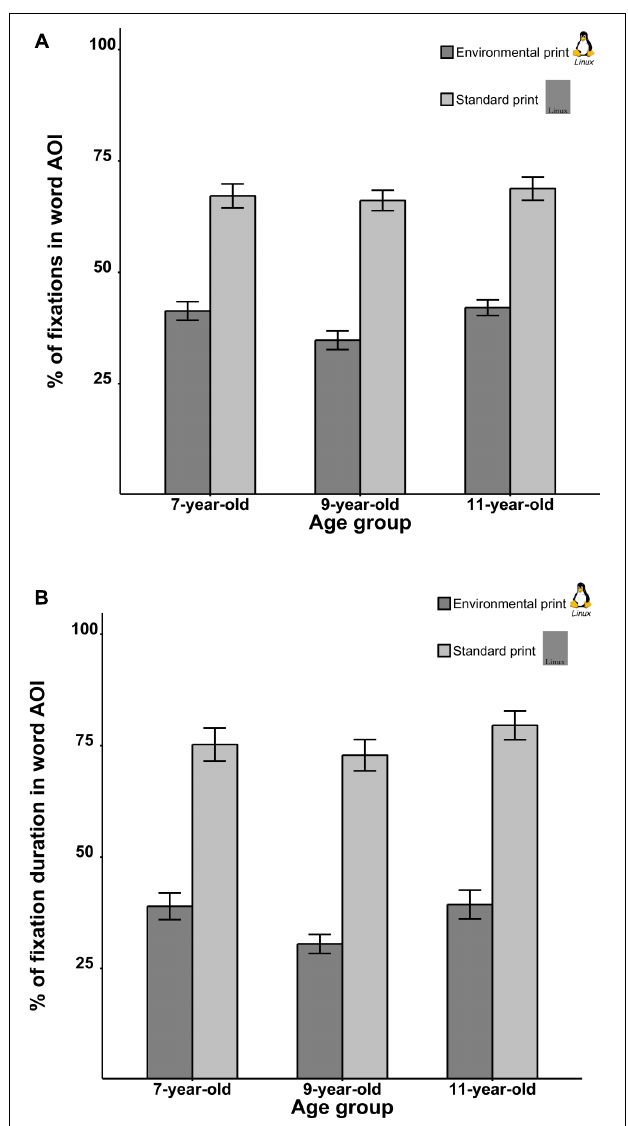
FIGURE 2 | Percentage of fixations (A) and fixation durations (B) for the word AOI in environmental prints and standard prints. Error bars denote ±